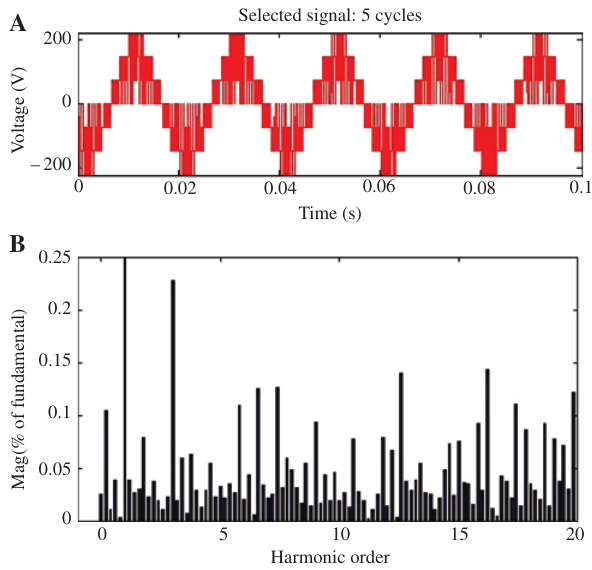
Figure 13: THD Analysis of Output Voltage with ANFIS. (A) Selected five cycles of voltage. (B)